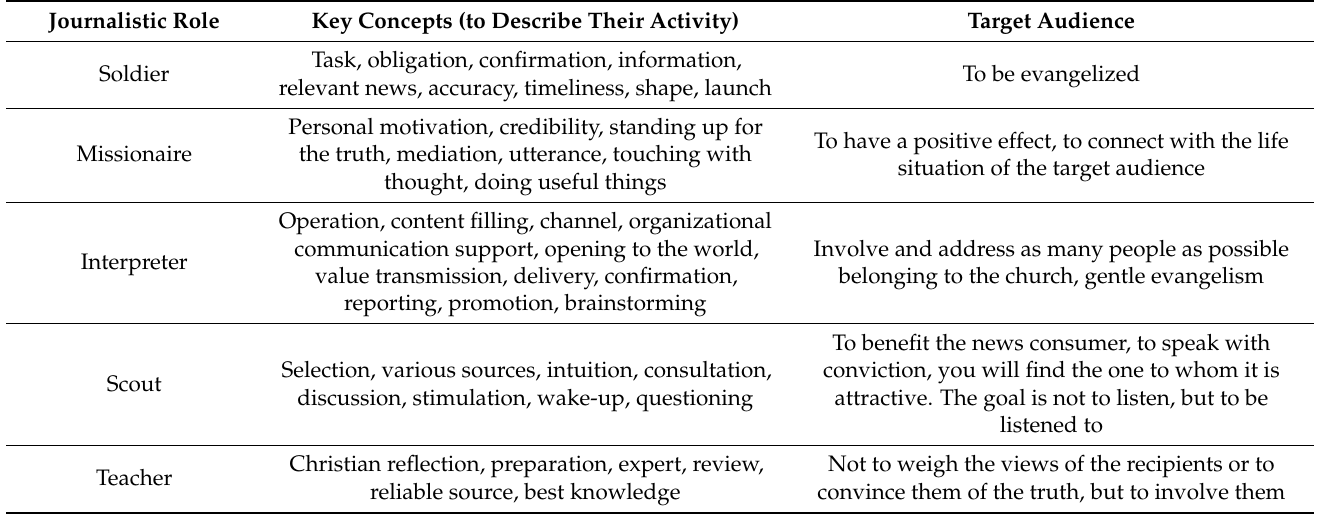
Table 3. Relationship between the role of journalist, key concepts, and the target